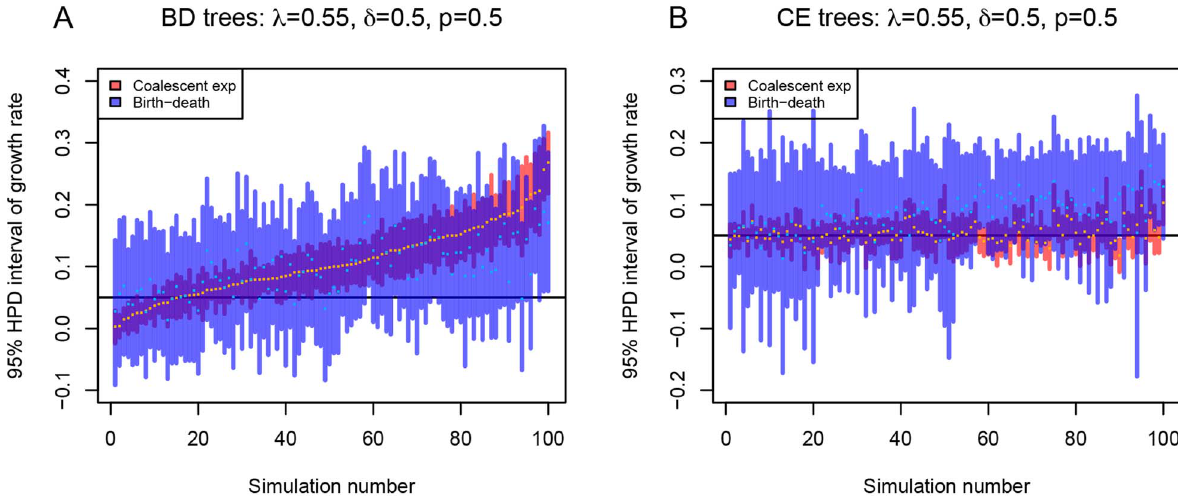
Figure 1. Comparison of the birth-death model and the coalescent model in estimating epidemic growth rate. For each plot, 100 trees simulated under the constant rate birth-death (BD) model with incomplete sampling (subfigure A) or coalescent (CE) model with exponential growth of the infected population (subfigure B) were analyzed assuming a birth-death model (blue bars) or a coalescent model with deterministic exponential population growth (red bars). 95% highest posterior density (HPD) intervals of the growth rate parameter are shown (y-axis). The trees are ordered (x-axis) by the median value of the posterior distribution of the growth rate parameter estimated by the coalescent (orange dot within the red bar) from the birth-death trees. Median of the posterior estimates for the growth rate parameter estimated by birth-death model is indicated as light blue dot within each blue interval. The true value of the growth rate parameter, i.e. the value under which the trees were simulated, is displayed as black horizontal bar. Here, we used l ~ 0 : 55, d ~ 0 : 5 and p ~ 0 : 5 ( R 0 ~ 1 : 1 ). See Figure S1 for the plots of other parameter settings.